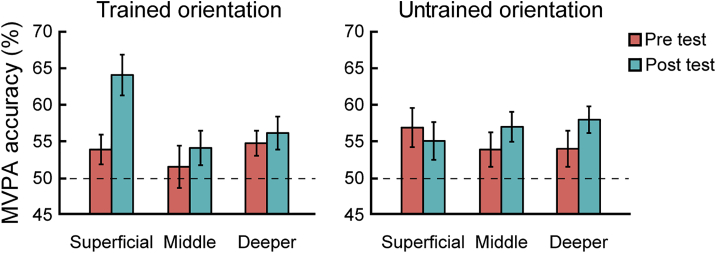
MVPA Results before and after Training across V1 LayersMVPA accuracy across V1 layers for the trained and untrained orientations presented at the trained location. Dotted line indicates MVPA accuracy at 50% chance. To further validate our MVPA results, we trained the classifier after shuffling the labels of the training dataset for 5,000 times. This analysis returned accuracies that did not differ significantly (all p > 0.618; false discovery rate [FDR] corrected), suggesting that our MVPA analysis extracted reliable voxel pattern information from the ROIs tested. Error bars indicate standard error of the mean across participants. See Figures S2 and S3 for the univariate and control analyses, respectively.